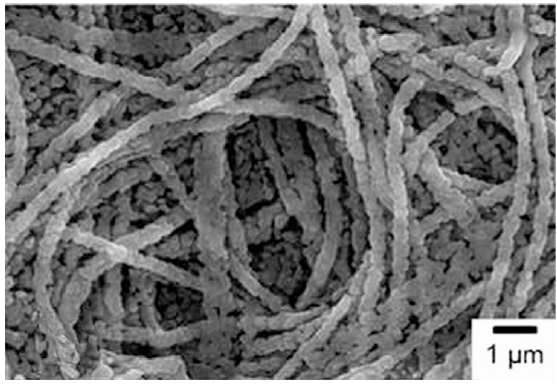
Figure 9. SEM image of MnTiO 3 fibers calcined at 800 °C [83].